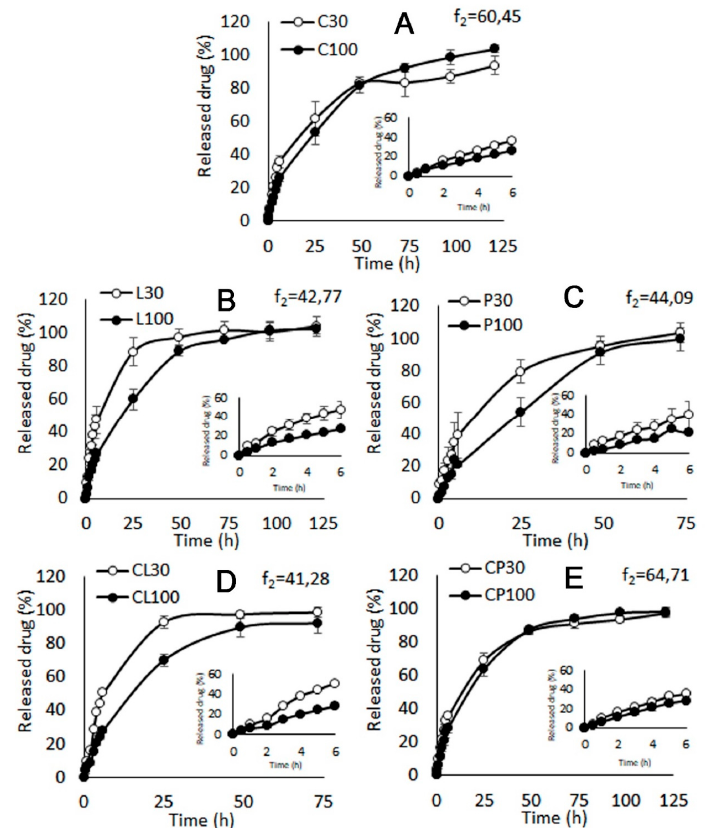
Figure 7. Drug release profiles in SVF from C ( A ), L ( B ), P ( C ), CL ( D ) and CP ( E ) batches containing 30 mg and 100 mg of TFV. Similarity factors are included in each graphics. The first six hours are shown in detail in the graphics in the bottom right corner.